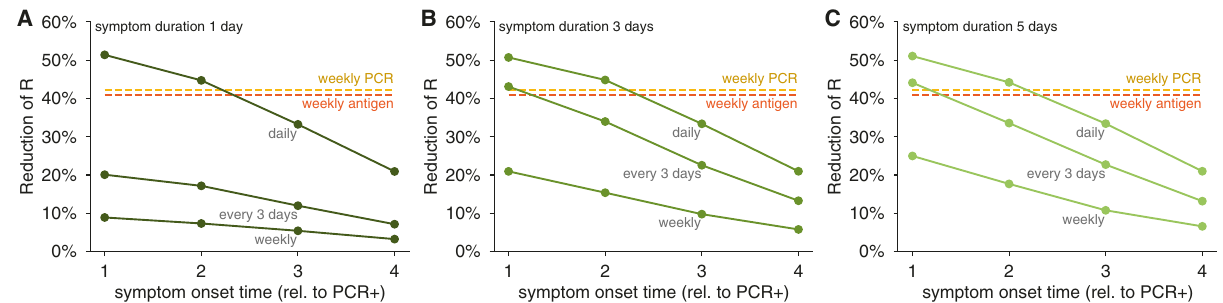
Fig. 4 Impact of the timing of onset and duration of olfactory dysfunction on its effectiveness to limit viral spread. Reductions of the reproductive number R by testing daily, every third day, or weekly for olfaction dysfunction are shown for olfactory dysfunction lasting ( A ) 1 day, B 3 days, and ( C ) 5 days, for varying symptom onset times, relative to when viral levels reach ~1000 virions/ml. We consider 80% participation in testing and 75% prevalence of olfactory dysfunction as a COVID-19 symptom, and 20% COVID-19-independent olfactory dysfunction in